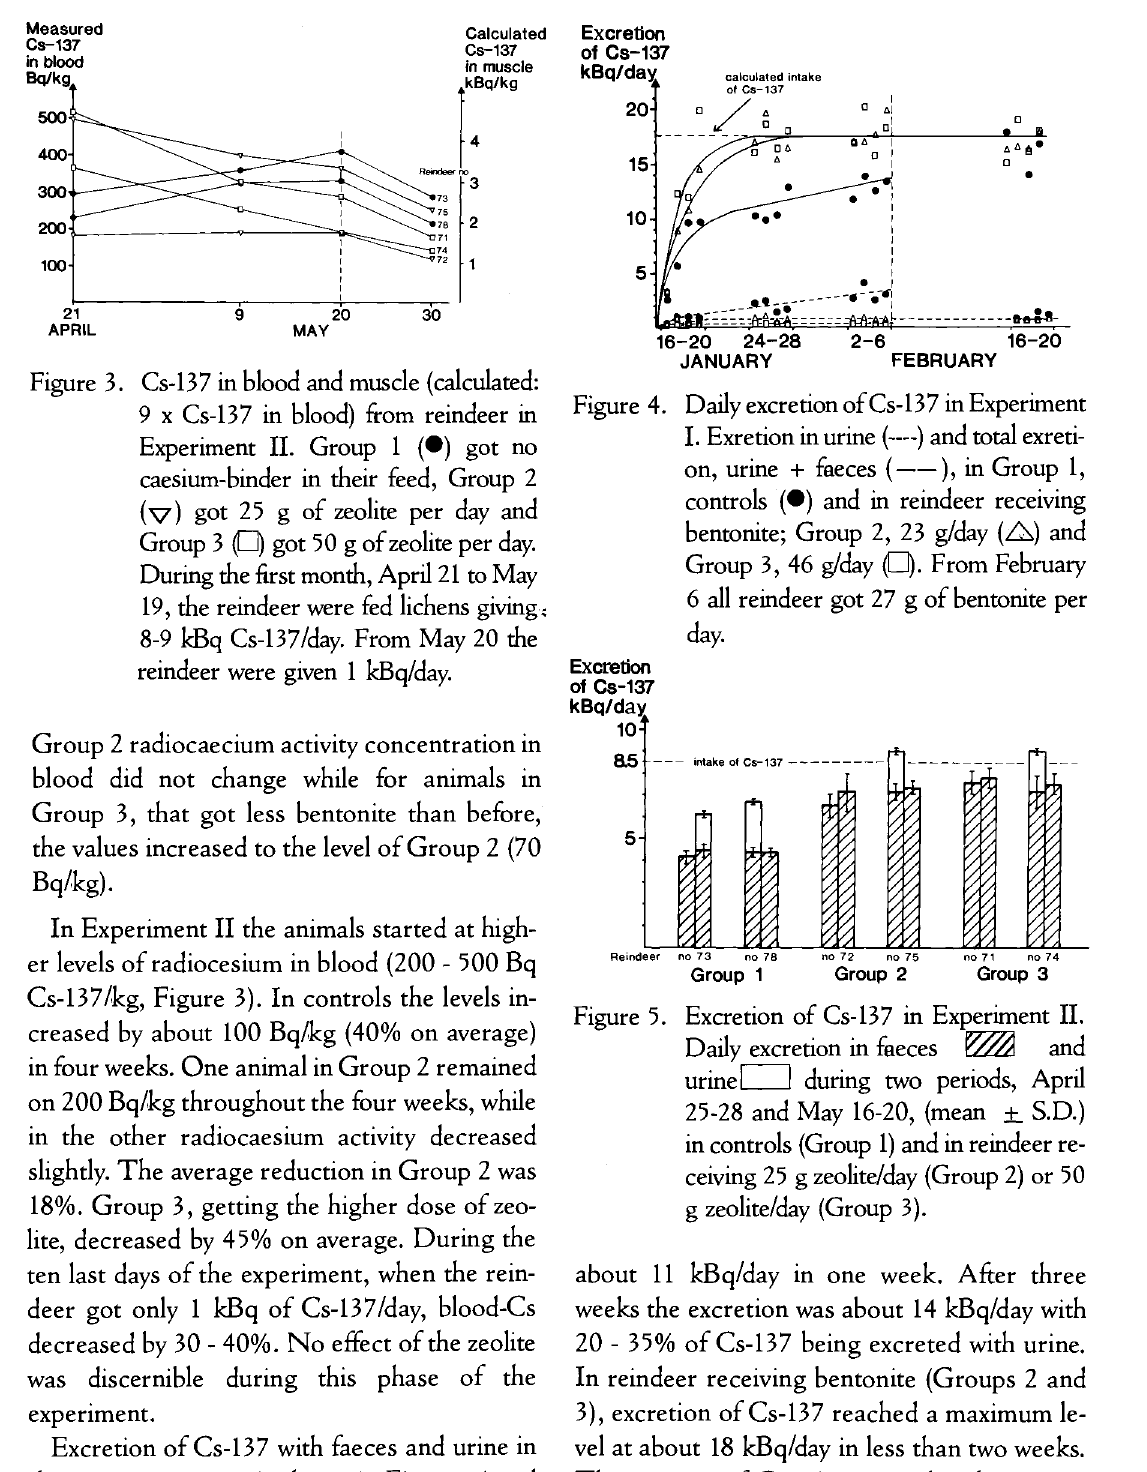
Figure 5. Excretion of Cs-137 in Experiment II. Daily excretion in faeces V//A and urine I H during two periods, April 25-28 and May 16-20, (mean + S.D.) in controls (Group 1) and in reindeer re ceiving 25 g zeolite/day (Group 2) or 50 g zeolite/day (Group 3). about 11 kBq/day in one week. After three weeks the excretion was about 14 kBq/day with 20 - 35%o of Cs-137 being excreted with urine. In reindeer receiving bentonite (Groups 2 and 3), excretion of Cs-137 reached a maximum le vel at about 18 kBq/day in less than two weeks. The amount of Cs-137 excreted with urine in these groups was 0.3 - 1.0 kBq/day which is 2 - 5%o of total excertion of